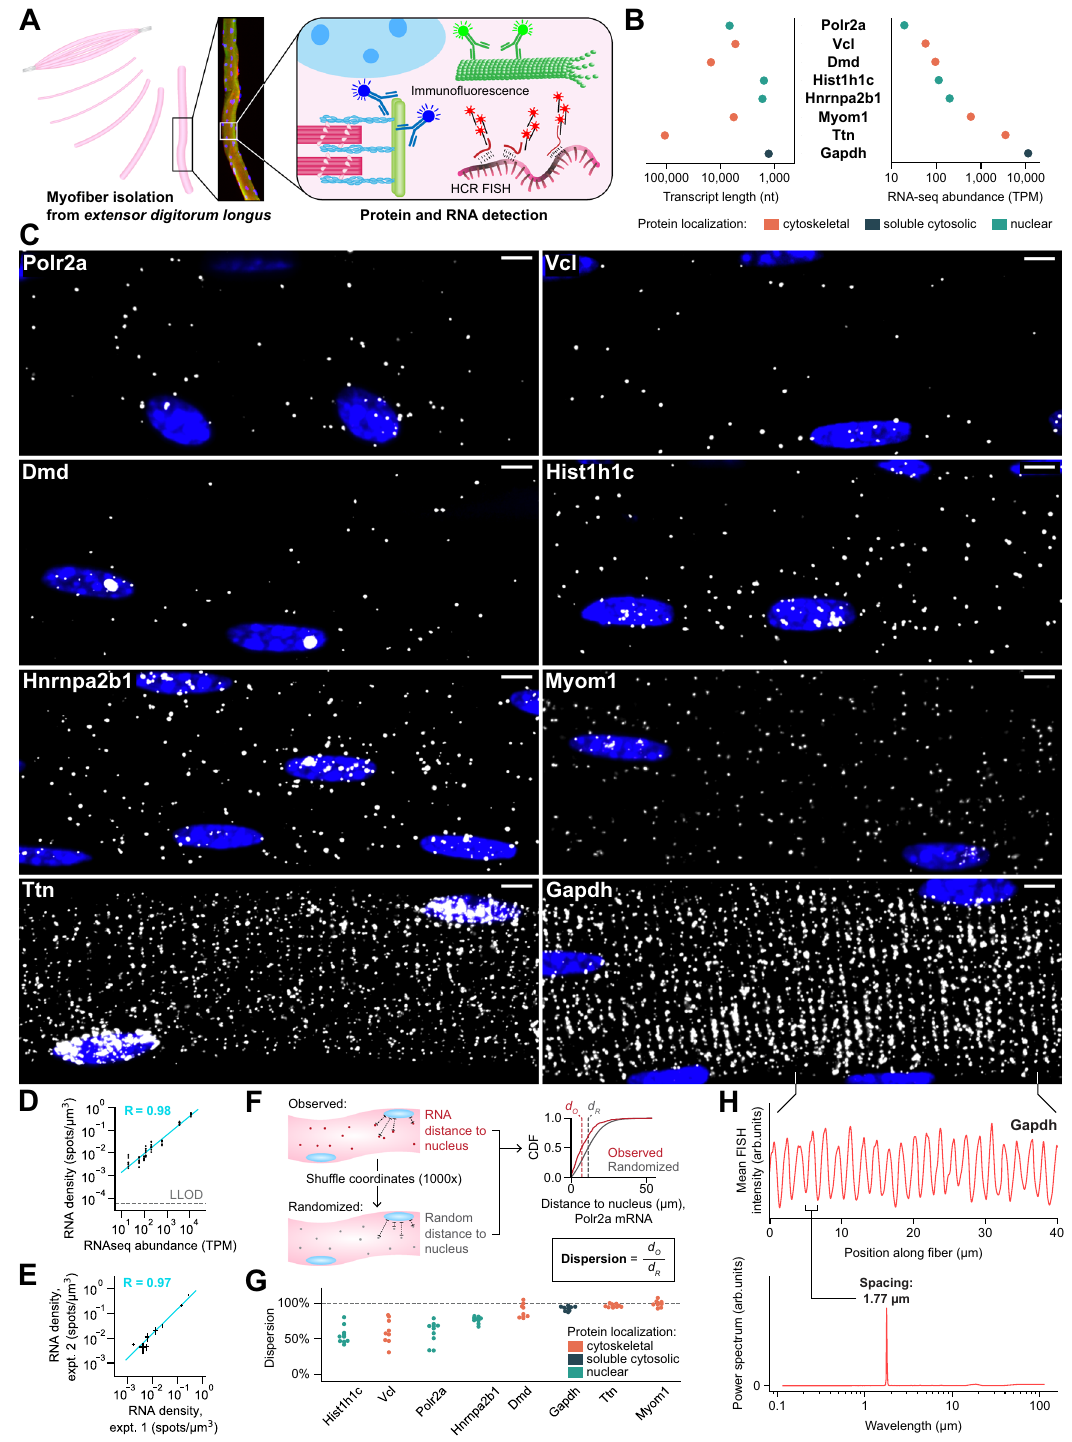
Fig. 1 RNAs can be reproducibly and accurately detected in myo fi bers by HCR FISH and are dispersed in the myo fi ber cytoplasm. A Schematic describing experimental strategy to label RNAs and proteins of interest in adult skeletal muscle. B Transcript length (nucleotides, nt) and abundance in tibialis anterior muscle (transcripts per million, TPM) for each RNA studied; colors represent encoded protein localization. C Representative FISH images for each RNA studied. Scale bars: 5 μ m. D RNA density (spots/ µ m 3 ) measured from FISH images compared with transcripts per million (TPM) values from a tibialis anterior RNAseq dataset. Dotted line is lower limit of detection (LLOD). Trendline: LLS regression; Pearson R = 0.98; p < 0.05, Wald test. E RNA densities compared across separate experiments. Black bars are the mean ± s.d. of RNA density. Experiment 1: n = 10 myo fi bers (Polr2a, Hist1h1c, Ttn, GFP) or n = 9 myo fi bers (Vcl, Dmd, Hnrnpa2b1, Myom1, Gapdh). Experiment 2: n = 3 myo fi bers. Trendline: LLS regression; Pearson R = 0.97; p < 0.05, Wald test. F Schematic describing percent dispersion calculation with example cumulative distribution function (CDF) for Polr2a RNA. G Percent dispersion for each RNA studied, points are colored as in Fig. 1B. Dotted line indicates fully uniform dispersion. H Mean Gapdh FISH signal intensity of myo fi ber in C plotted for 40 µ m along the longitudinal axis (top). The power spectral density of this signal